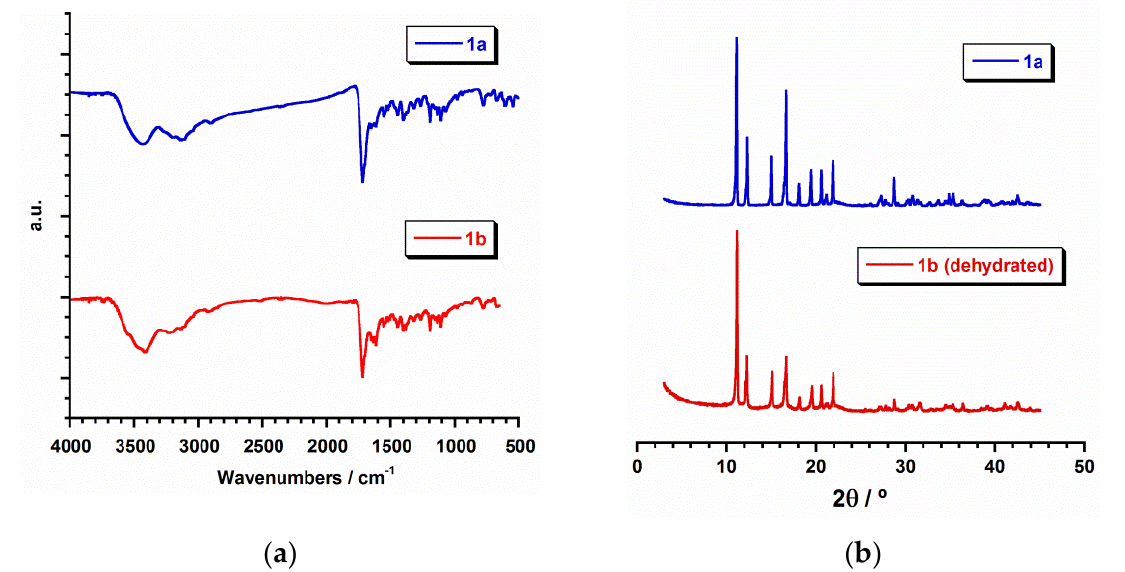
Figure 2. ( a ) IR spectra (Transmission mode) for 1a (blue) and 1b (red); ( b ) plot of the experimental powder X-ray diffraction (PXRD) patterns profile (2 θ /°) in the range 0–50° for 1a (blue) and dehydrated 1b (red).